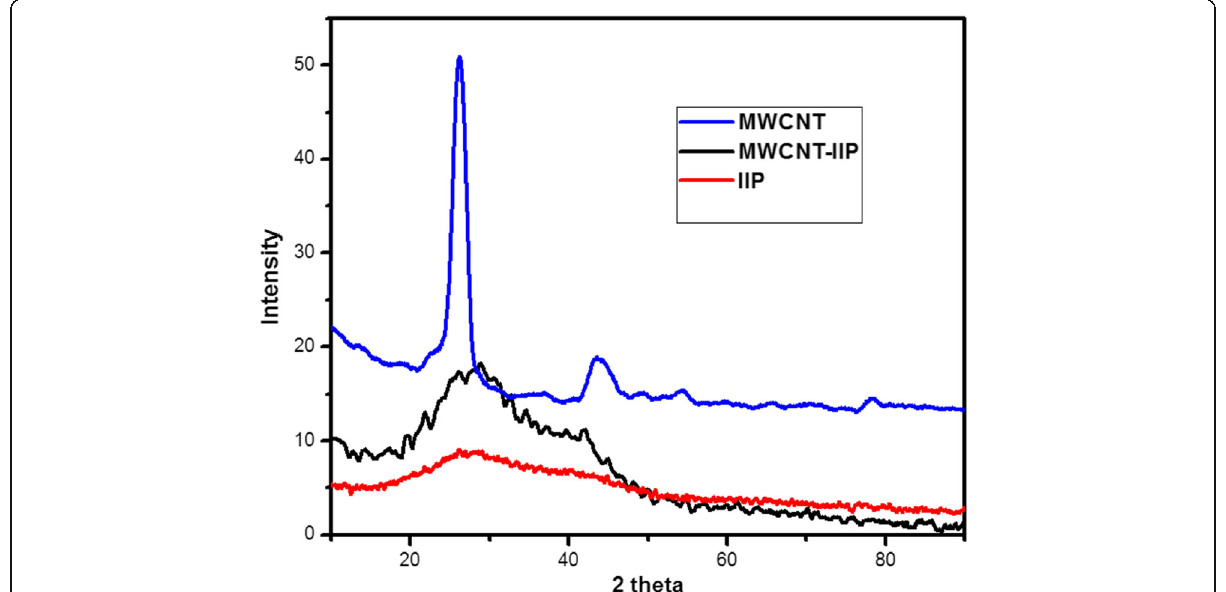
Fig. 2 Powder X-ray diffraction patterns of a MWCNT, b MWCNT-IIP, and c IIP